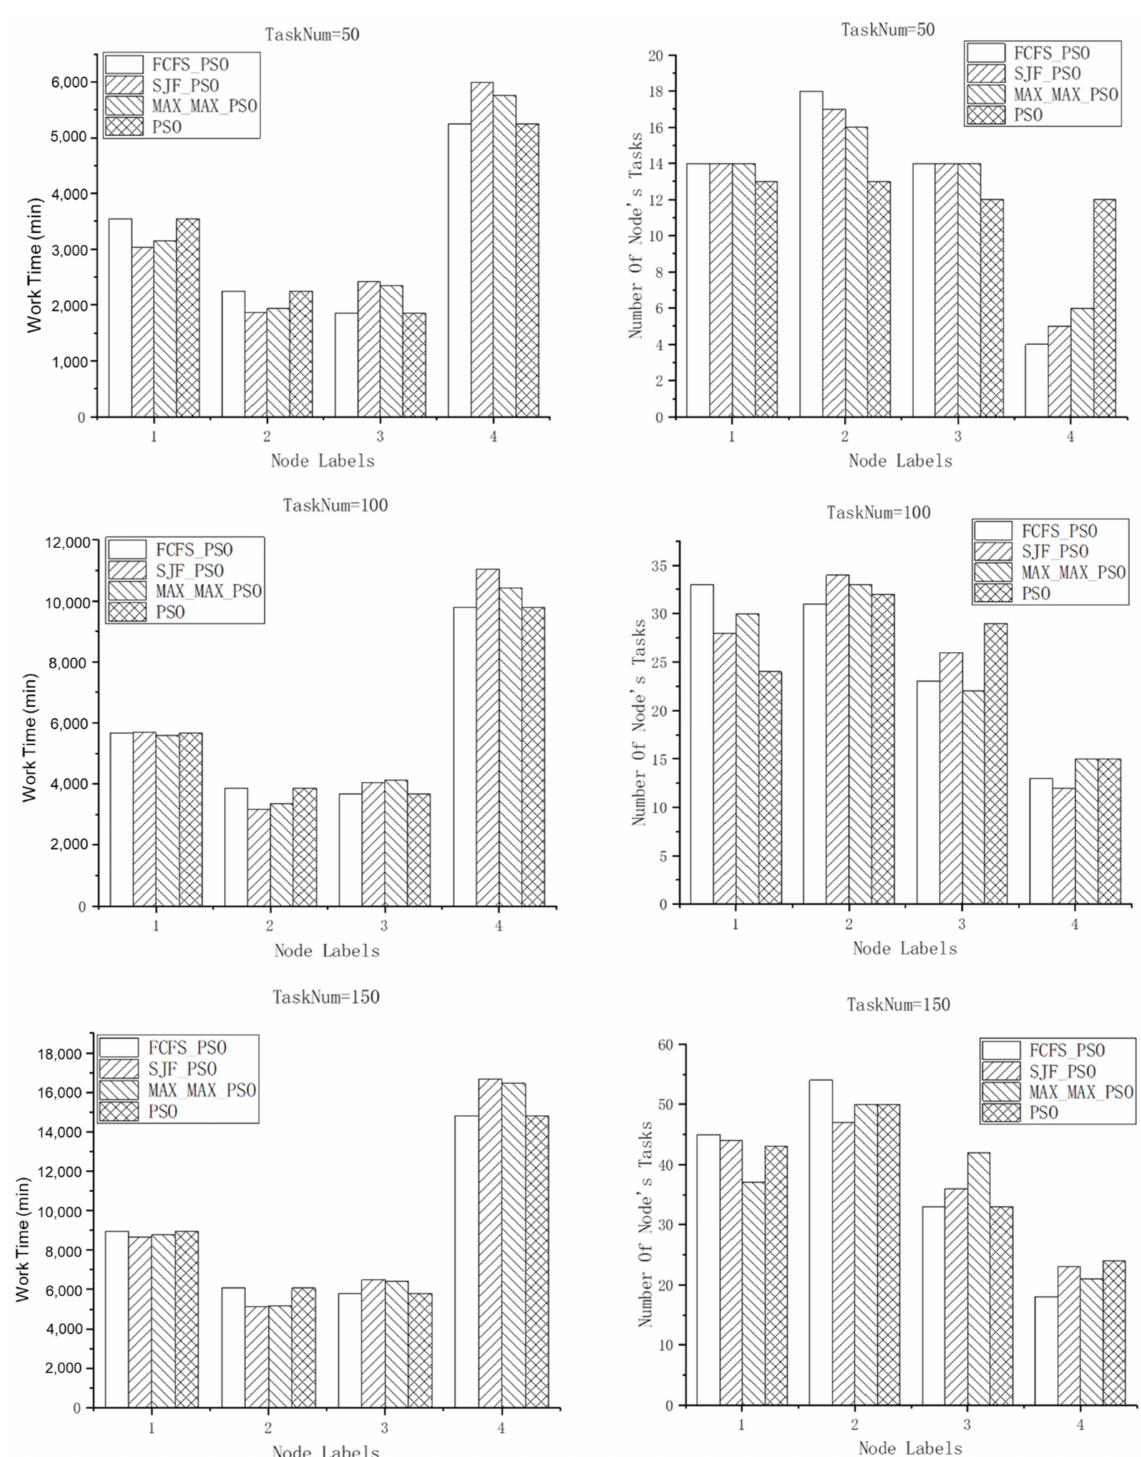
Figure 2. The working state of